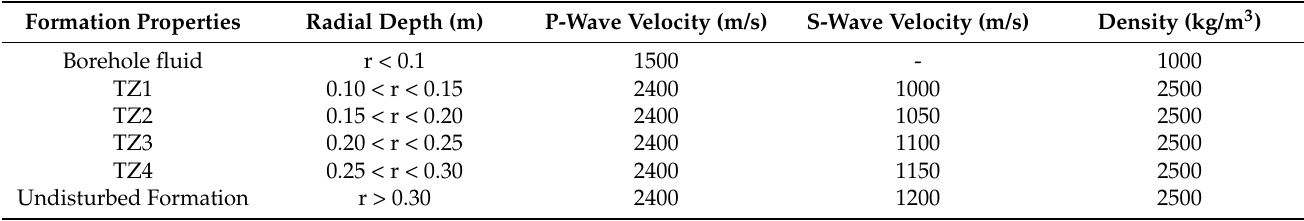
Table 1. Parameters of radial variation-formation